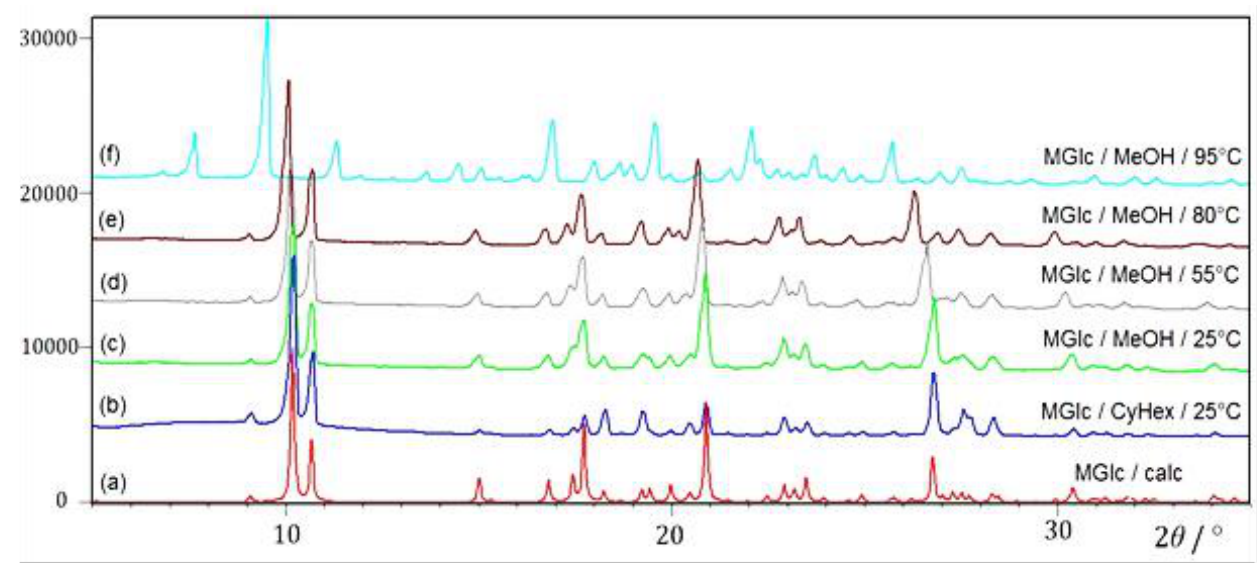
Figure 4. Powder X-ray diffraction patterns of the samples of MGlc crystallised from cyclohexane ( b ) and from methanol ( c – f ), were recorded at 25, 55, 80, and 95 °C. The reference pattern of MGlc ( a ) calculated from single-crystal data is given in red. Table 2. Crystal data and selected structure refinement details for the monomers MGlc and AGlc (polymorphs M , O , M - LT